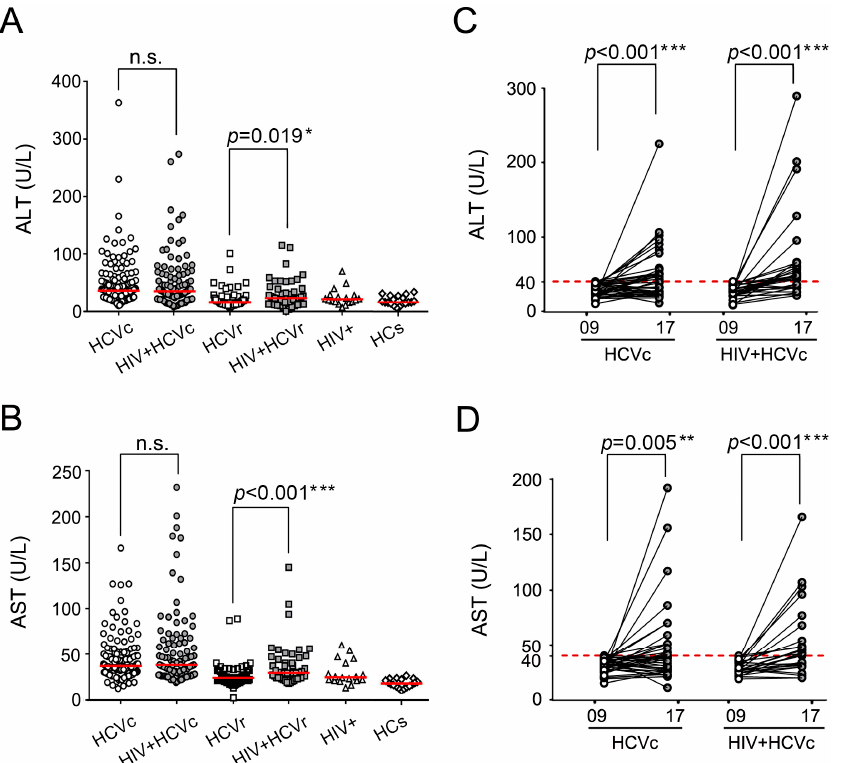
Figure 2. Comparison of ALT and AST levels and variations among different subgroups. ( A ) ALT and ( B ) AST levels in different subgroups at the first follow-up in 2009. The variation of ( C ) ALT and ( D ) AST levels from 2009 to 2017. To maintain neutrality, only individuals with normal test results in 2009 were compared for variance. The red solid line indicates the median levels. The red dashed line indicates normal values of reference. (*, p < 0.05; **, p < 0.01; ***, p < 0.001).